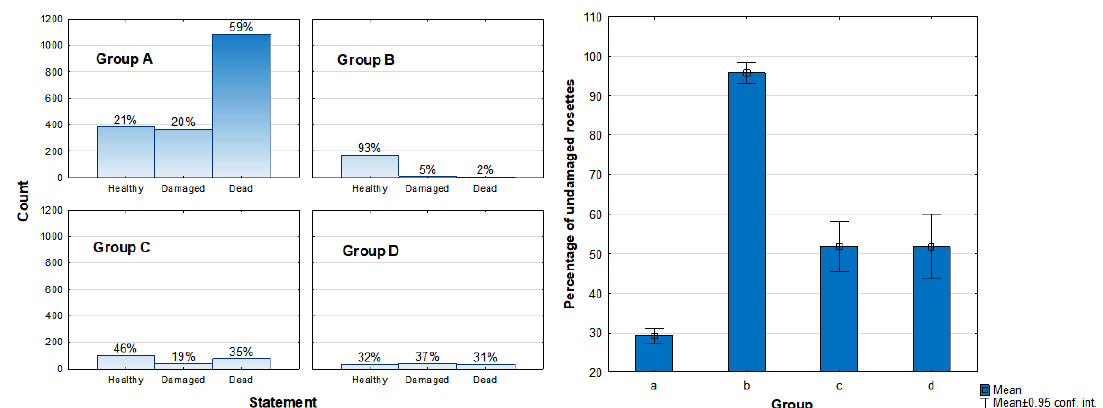
Figure 10. ( a ) The health status of inventoried groups of trees ( left ). ( b ) Percentage range of undamaged rosettes in crowns of the inventoried groups ( right ). Group A is the Jabal Samhan population, B and C are populations located at the eastern parts of Jabal al Qamar, and group D is located at the western part of Jabal al Qamar.